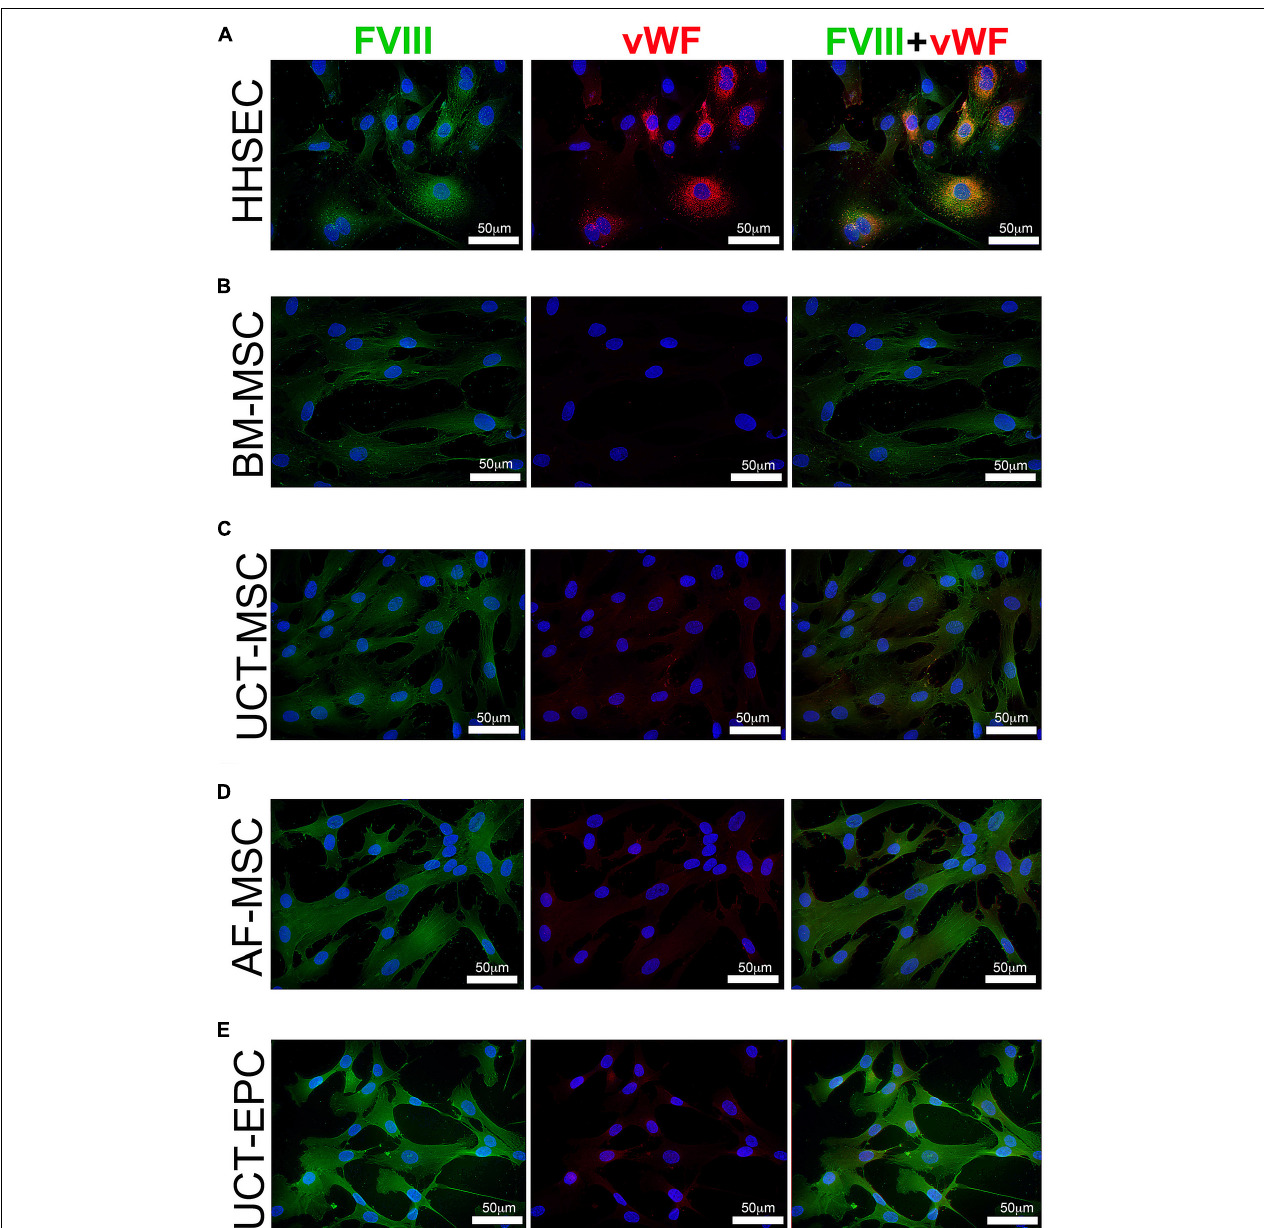
FIGURE 4 | Immunofluorescence visualization of FVIII and vWF expression. Cells were grown in chamber slides, fixed, and stained with antibodies to FVIII (green) and vWF (red), while nuclei were counterstained with DAPI (blue). (A) HHSEC (positive control) demonstrate high level expression of both FVIII and vWF, and these two proteins colocalize and exhibit a punctate staining pattern consistent with storage within Weibel-Palade bodies (WPB). In contrast, while expression of MMLV-encoded HSQ (FVIII; green) can readily be detected in all transduced cell types, no vWF (red) staining is seen in BM-MSC (B) , and only very low levels of staining for vWF (red) are seen in UCT-MSC (C) , AF-MSC (D) , and UCT-EPC (E) . Moreover, staining for the exogenous MMLV-encoded FVIII (green) is diffusely spread throughout the cytoplasm, suggesting that it is not being stored within WPB as it is in